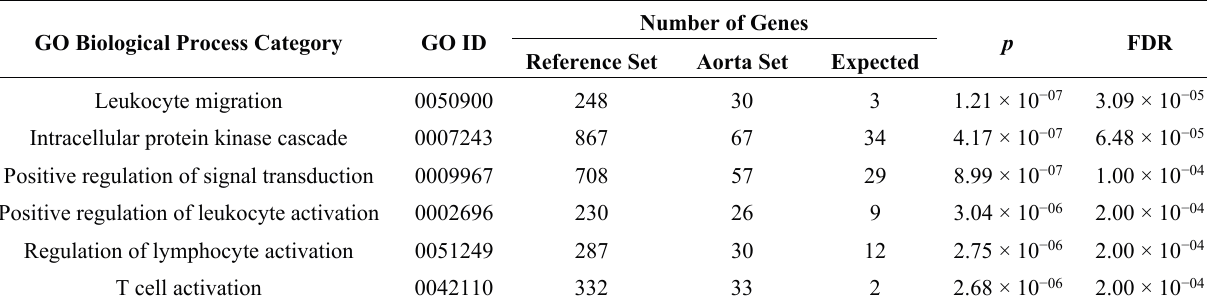
Table 5. Enriched Gene Ontology (GO) biological process categories for the target genes identified in AAA ChIP-chip with transcription factors RUNX1, ELF1, ETS2 and STAT5. Number of Genes GO Biological Process Category GO ID p FDR Reference Set Aorta Set Expected Leukocyte migration 0050900 Intracellular protein kinase cascade